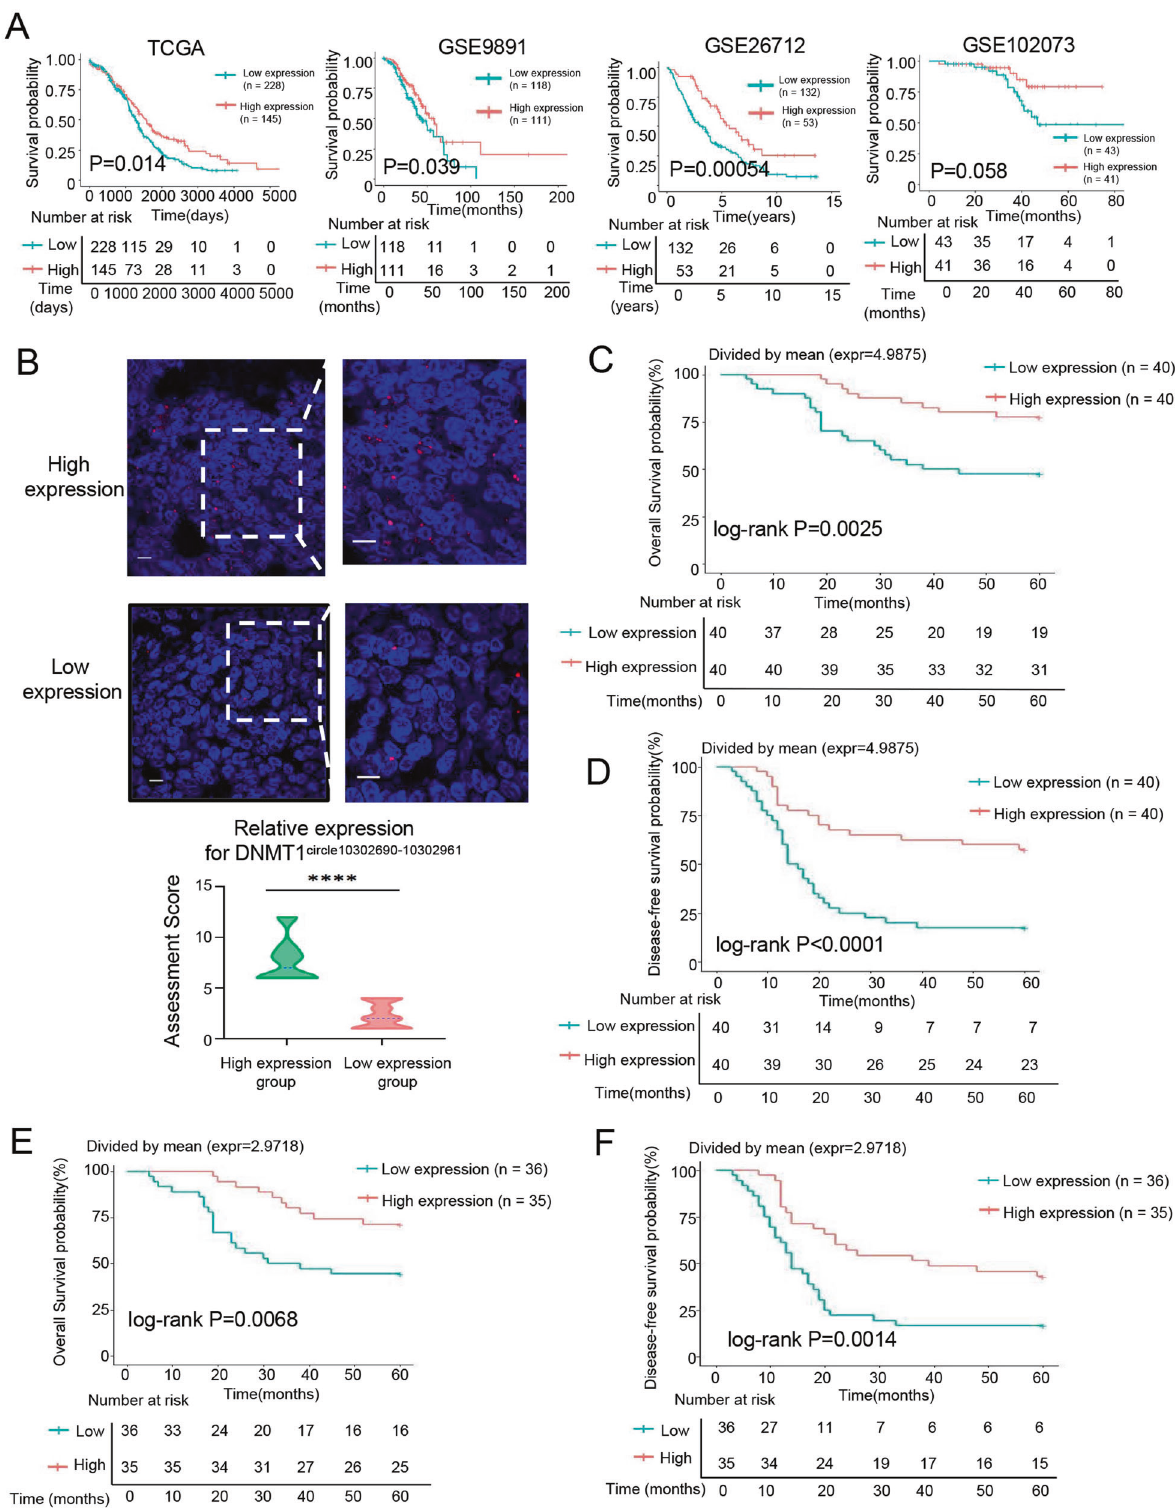
Fig. 6 The decrease of DNMT1 circle10302690-10302961 is associated with poor prognosis in HGSOC patients. A The Kaplan – Meier survival analysis of DNMT1 expression levels in ovarian cancer patients according to TCGA and GEO (GSE9891, GSE26712, GSE102073), respectively. B The representative images of FISH assays for DNMT1 circle10302690-10302961 in FFPE tissues of HGSOC tumors. High expression, upper; Low expression, lower. The Kaplan – Meier survival analysis of 80 HGSOC patients strati fi ed by DNMT1 circle10302690-10302961 expression in FFPE tissues of primary tumors for overall survival (C) or disease-free survival (D) . The Kaplan – Meier survival analysis of 71 HGSOC patients with metastasis strati fi ed by DNMT1 circle10302690-10302961 expression in FFPE tissues of metastatic tumors for overall survival (E) or disease-free survival (F) . The data were presented as mean ± SD; **** P